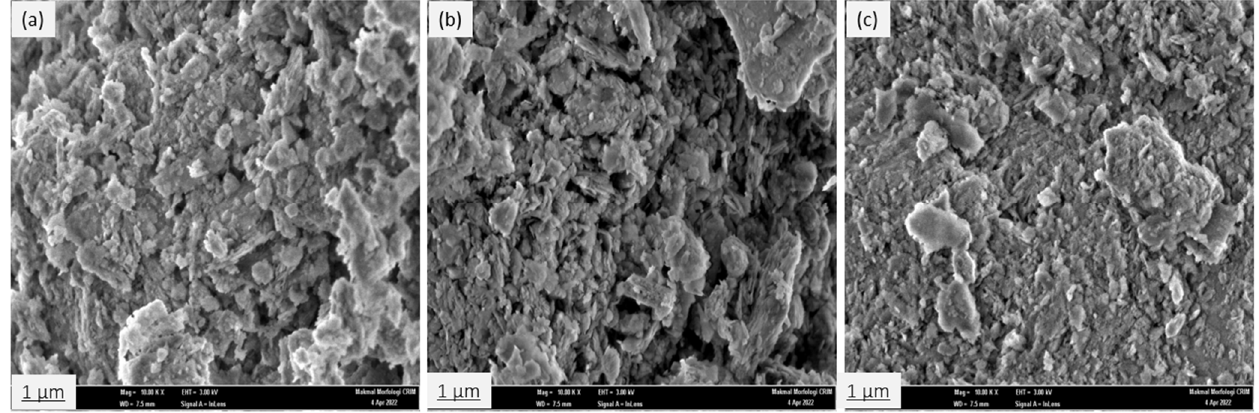
Figure 16. The FESEM image of ( a ) NZ, ( b ) PZ, and ( c ) SZ after the adsorption of thorium, at a magnification of 10,000×.